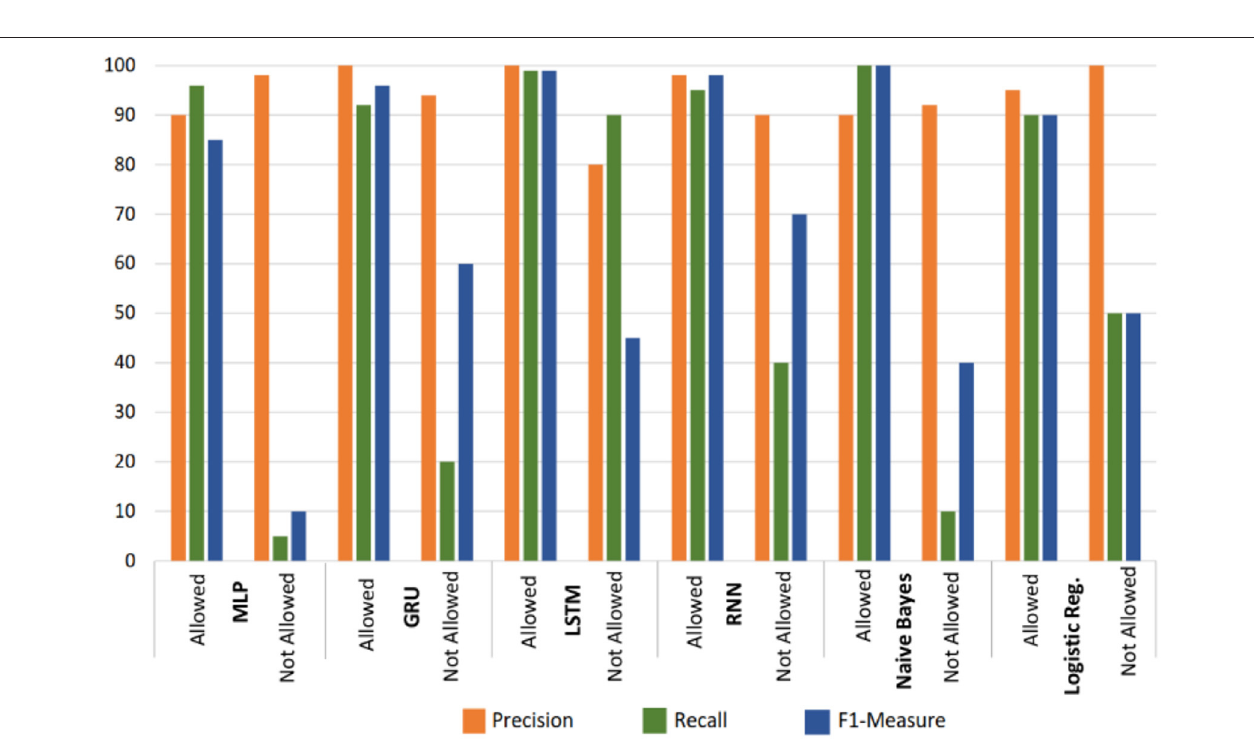
FIGURE 12 | Result of the Classification for Deep and Machine Learning classifiers.